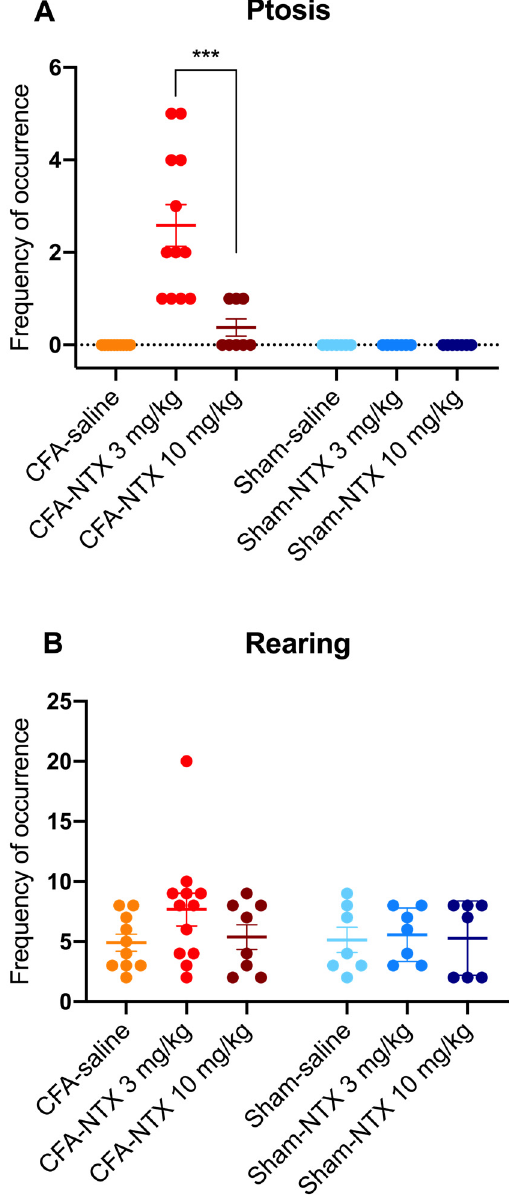
Figure 3. NTX-evoked opioid withdrawal behaviors in CFA-21d male Wistar rats. The column-scatter graphs show the frequency of occurrence of withdrawal-associated behaviors (number of behavior episodes counted over the 60 min observation period) after administration of 3 mg/kg NTX, 10 mg/kg NTX, or saline to CFA-injured rats on day 21 post-CFA intraplantar injection (remission phase; n = 12, n = 8 and n = 10, respectively) or to sham-injured rats on day 21 post-saline intraplantar injection ( n = 7, n = 7 and n = 7, respectively). ( A ) Ptosis, ( B ) rearing. Individual points represent data from every animal, horizontal lines depict the mean, and vertical bars depict the SEM. *** p < 0.001 (3 mg/kg NTX versus 10 mg/kg NTX in CFA-21d rats). See main text for abbreviations.